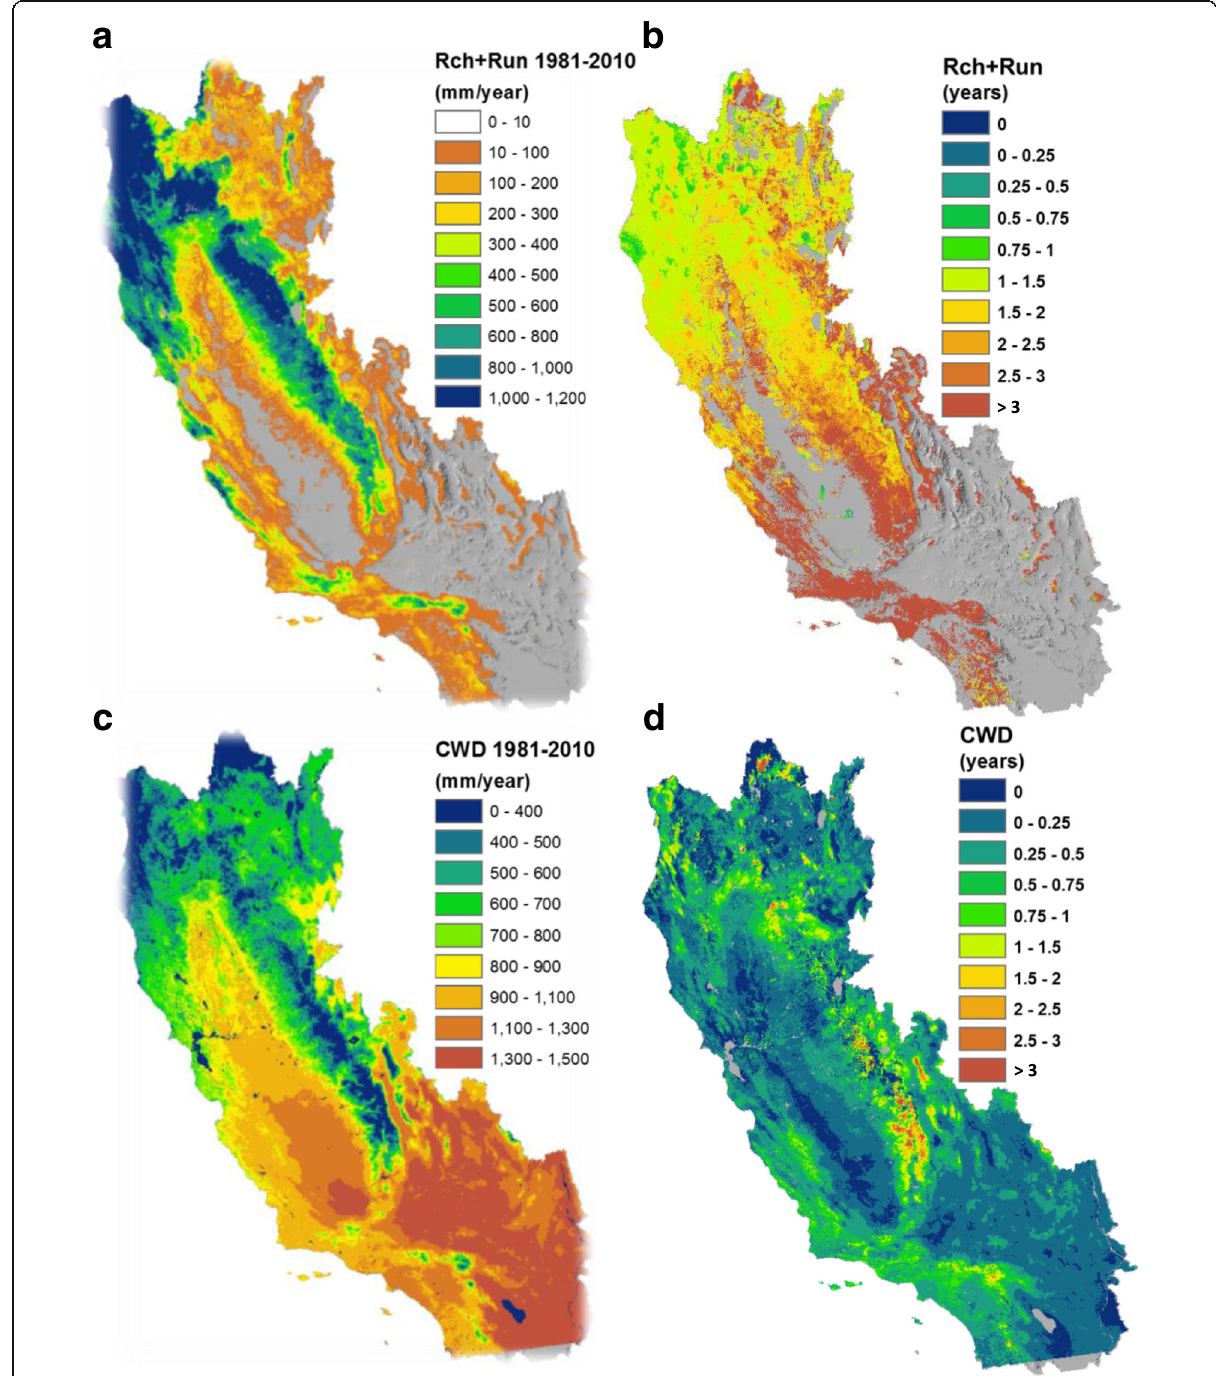
Fig. 3 Calculations of statewide drought metrics of water supply (recharge plus runoff) for a average annual conditions and b years of missing water supply accumulated for drought water years 2012 – 2016 and landscape drought (climatic water deficit) for c average annual conditions and d years of accumulated landscape stress for drought water years 2012 – 2016. Gray in a and b signifies that there is no average annual recharge